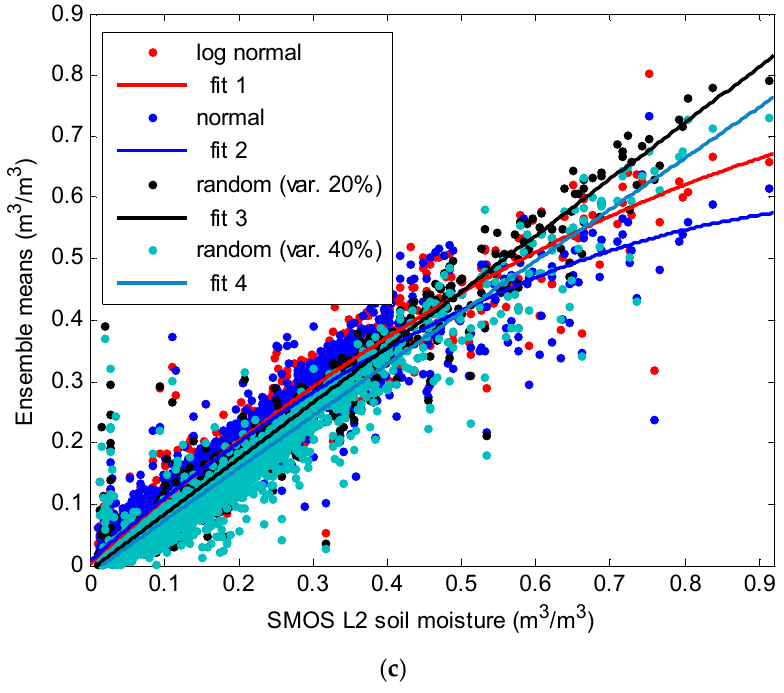
Figure 1. Different rescaling curves: ( a ) by size (at the same variance of 40%, same normal distribution); ( b ) by variance (at the same ensemble size of 24, the same normal distribution); ( c ) by error distribution (at the same ensemble size of 12).